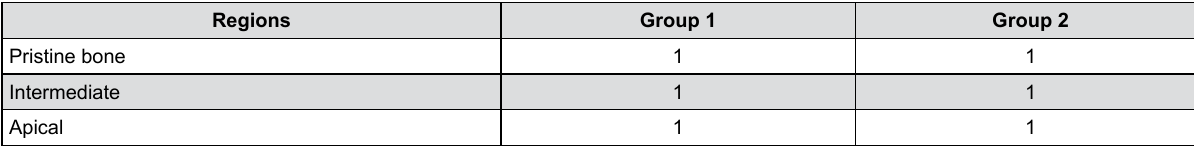
Figure 5- Score assigned to TRAP immunostained after six months of bone repair in both groups for each region of